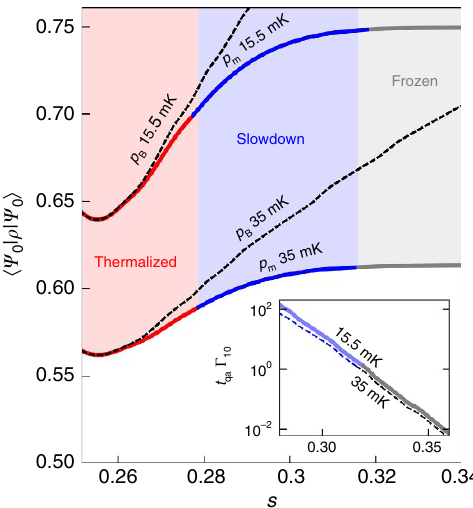
Figure 4 | Multiqubit freezing. Solid lines correspond to the modelled population p m of the lowest-energy eigenstate along the quantum annealing process using h L ¼ 0.44 at 15.5mK (top line) and 35mK (bottom line). Dashed lines correspond to the thermal equilibrium population p B . In the thermalization phase (red) the transition rate is fast and the population remains close to thermal equilibrium. As the multiqubit energy barrier increases, the transition rates are exponentially reduced with s , as shown in the inset. We define the slowdown regime (blue) as t qa G 1 - 0 o 10 and the frozen regime (grey) as t qa G 1 - 0 o 0.1. Comparing the data at 15.5 and 35mK, we see a small change in the transition rate relative to the larger change in the thermal equilibrium ground-state population. Therefore, the probability of success is lower at higher